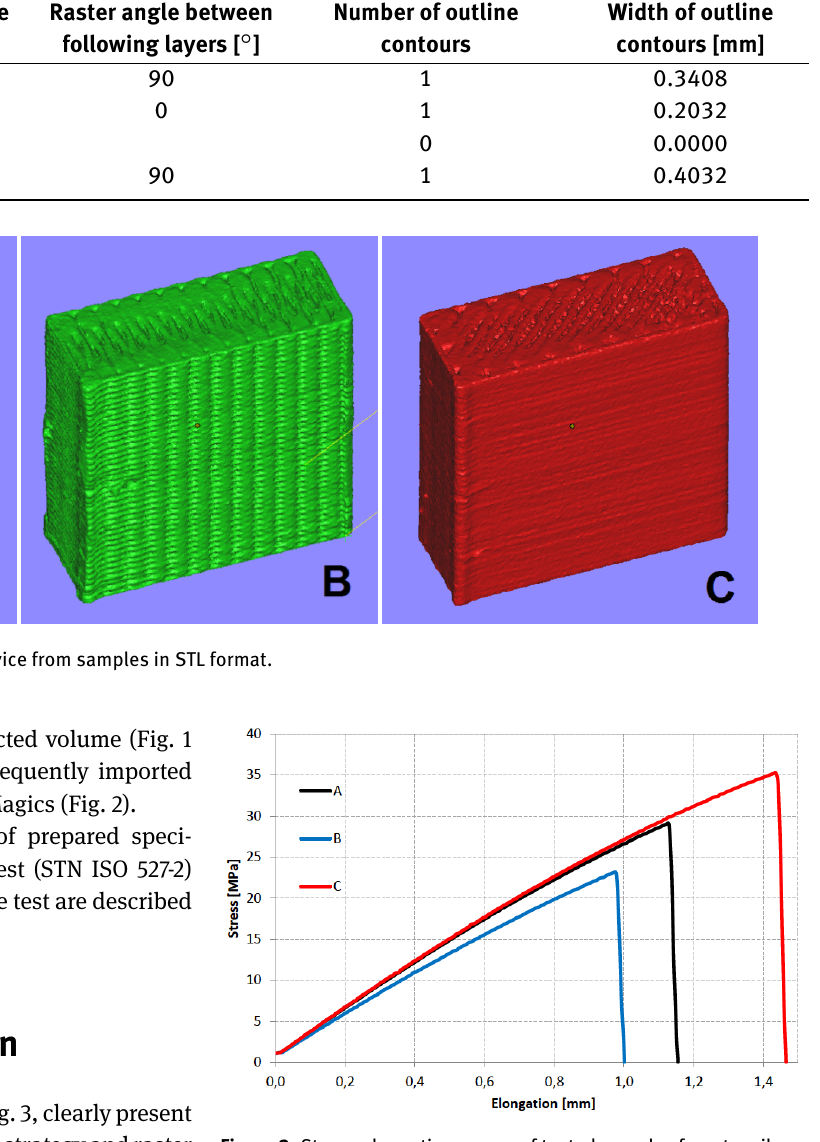
Figure 3: Stress-elongation curves of tested samples from tensile